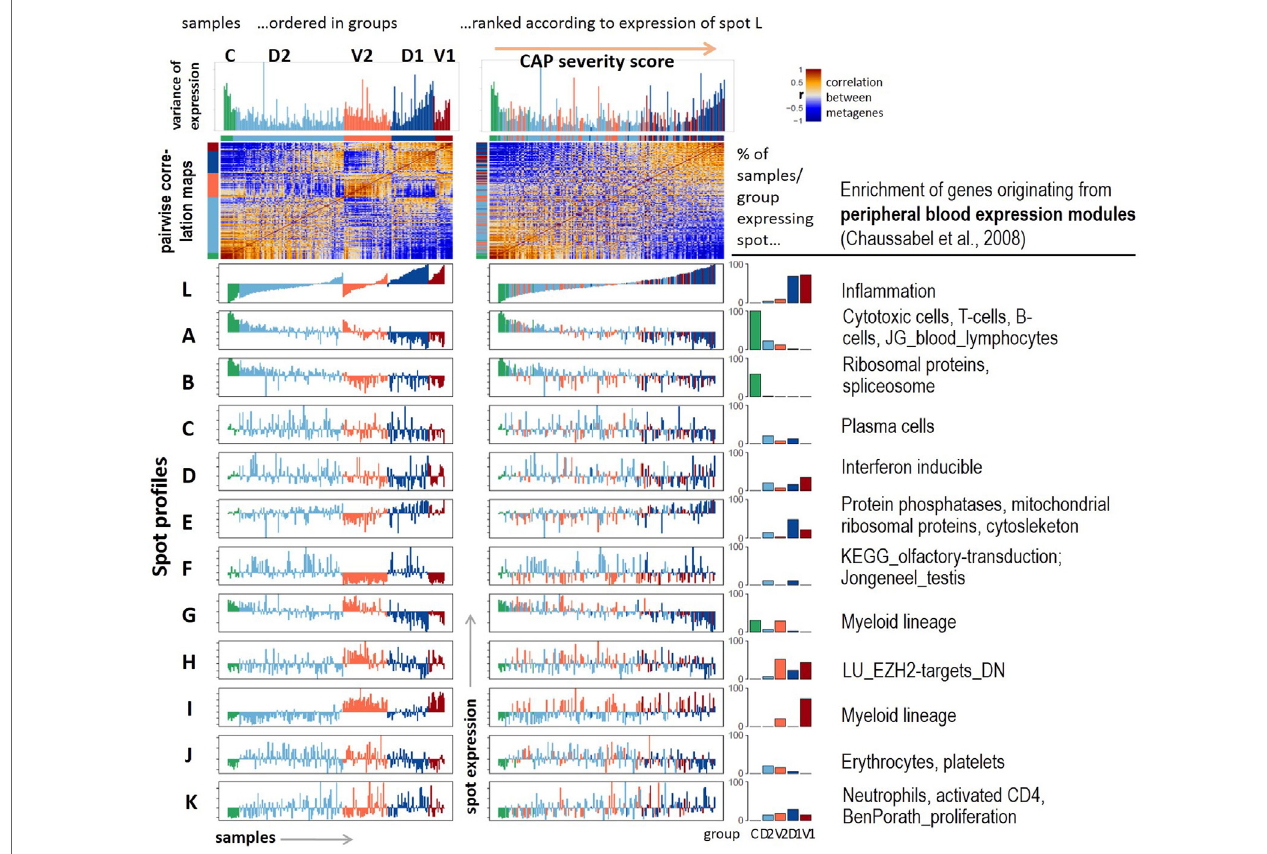
FigUre 2 | Profiling of the expression modules: pairwise correlation maps of the sample self organizing maps and of the expression profiles of the spot modules were generated in two variants of sample sorting using either the group-classification (left part) or the inflammatory activity as estimated by the mean gene expression of spot L (right part). The barplots in the right part show the percentage of samples of each class expressing the respective spot. Healthy blood signatures enriched in the spots ( p < 10 − 7 , Fishers exact test) were taken from Ref. (20, 31) and other signatures from Ref. (32,